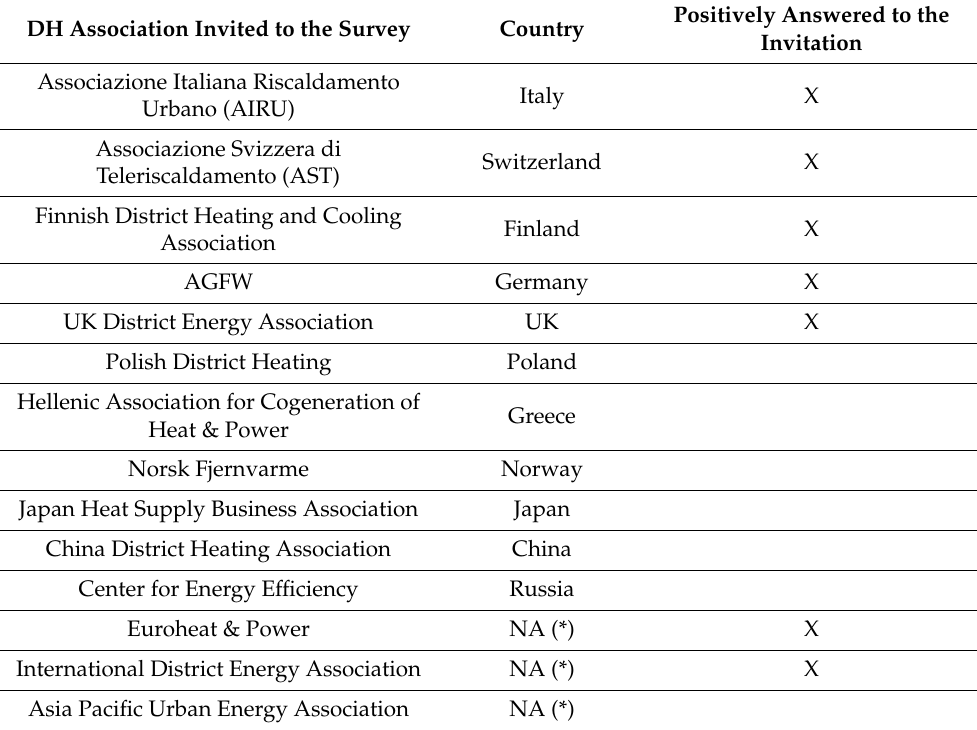
Table 1. Invited association to the proposed expert opinion